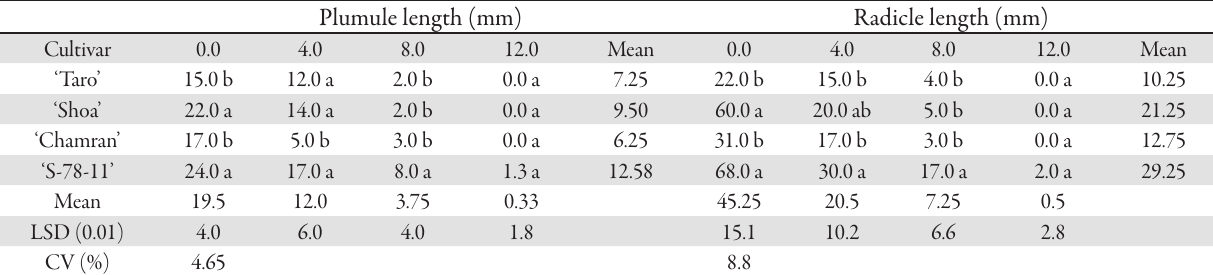
Different letters in each column indicates significance at P